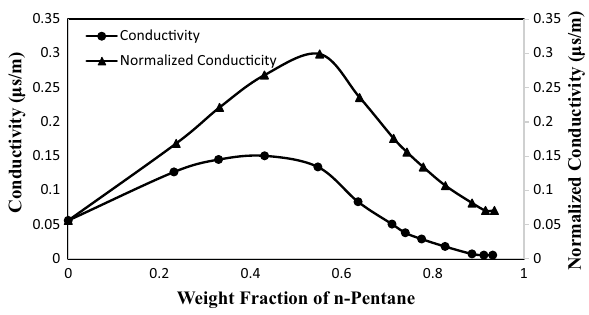
Fig. 22 Conductivity and normalized conductivity for crude A-pre- cipitant mixture (Fotland et al. 1993)